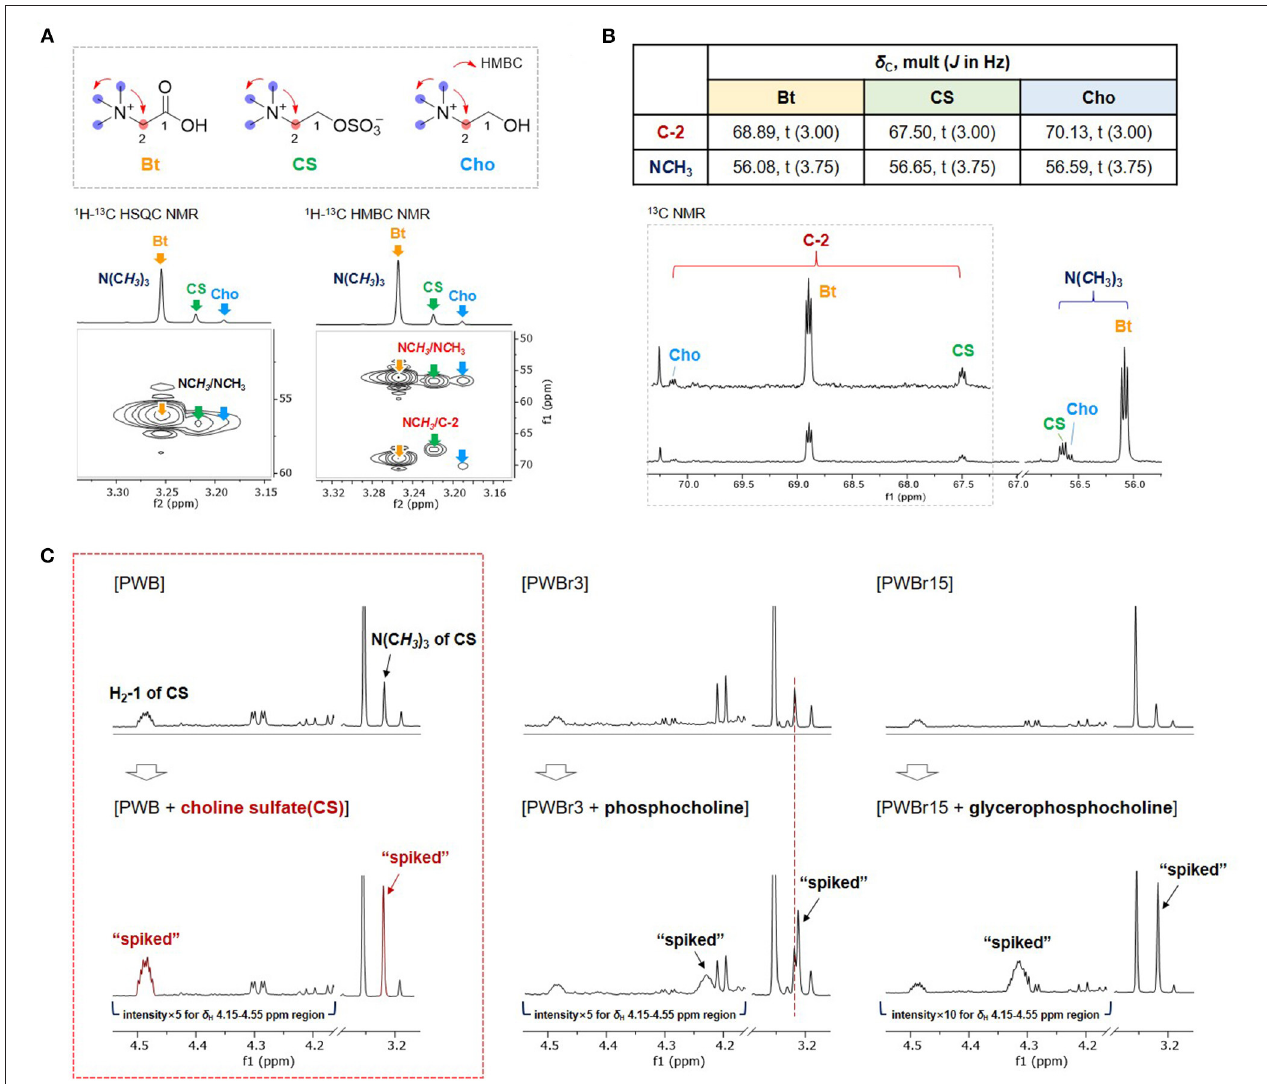
FIGURE 2 | Comparison of (A) 1 H- 13 C HSQC and HMBC correlations and (B) 13 C NMR signals of C-2 and N C H 3 of betaine (Bt), choline sulfate (CS), and choline (Cho) in PWB. (C) Spiking 1 H NMR experiments with commercial standards of CS, phosphocholine, and